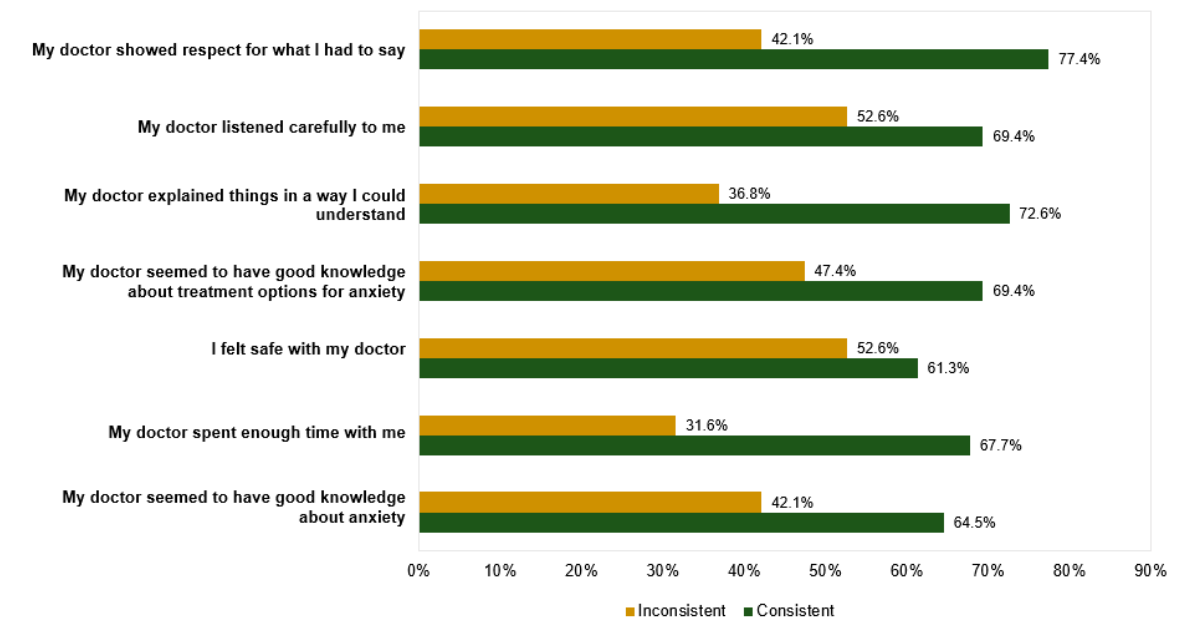
Figure 5. Comparison of agreement regarding perceptions of GP items between participants who received a treatment consistent with their preferences (“consistent”, n = 62) and those who did not (“inconsistent”, n = 19).